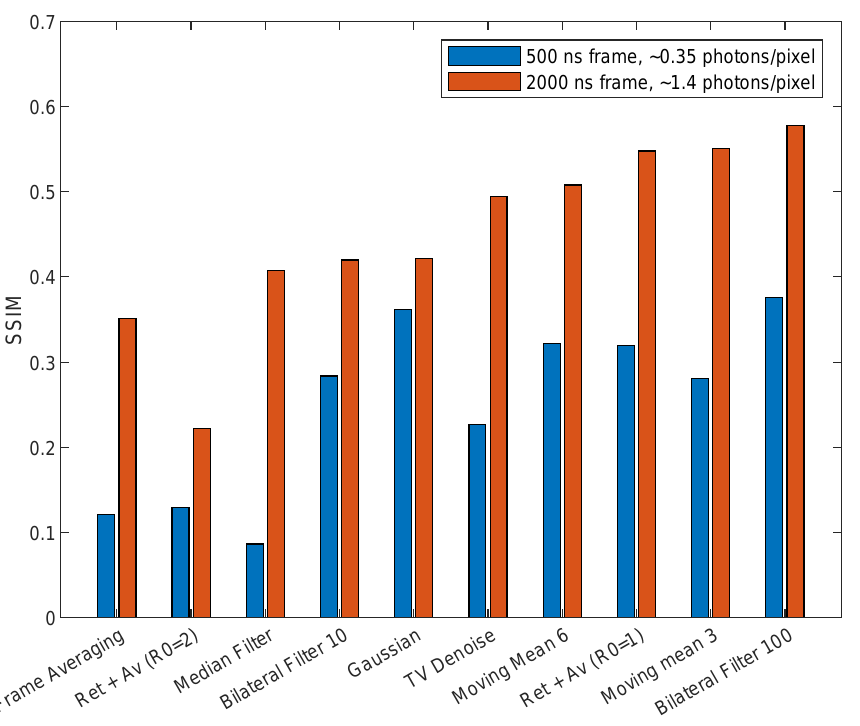
Figure 8. Comparison of the resulting SSIM from numerous different reconstruction methods using sparse photon data from the SPAD camera. All methods were tested at both 0.5 µ s and 2.0 µ s total exposure time, corresponding to about 0.35 and 1.4 photons per pixel respectively. Each reconstruction listed was performed 100 times and the displayed image reconstruction quality metric is the mean of these 100 separate reconstructions. Retrodiction and averaging is shown as Ret +